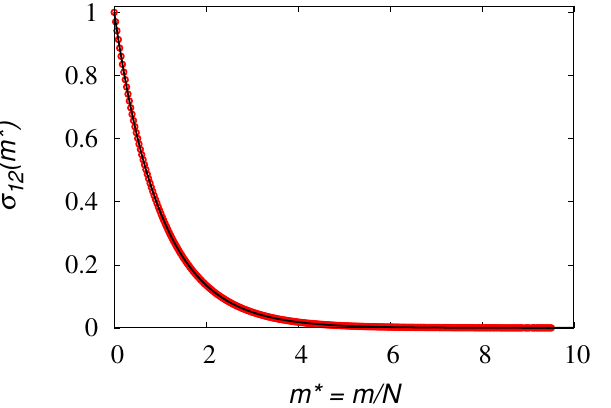
Figure 3. Stationary density p ∗ ( z ) vs. z , where z = z h ,2 is the second entry of the ensemble ele- ments obtained from Monte Carlo simulations of the CMT at n = 2 with the dichotomic random perturbation (17) and (18). Symbols (( (cid:3) ) refer to p = 3, ( ◦ ) to p = 2, ( • ) to p = 1) represent the stochas- tic simulation results of the asymptotic CMT dynamics, solid line represents the normal distribution.